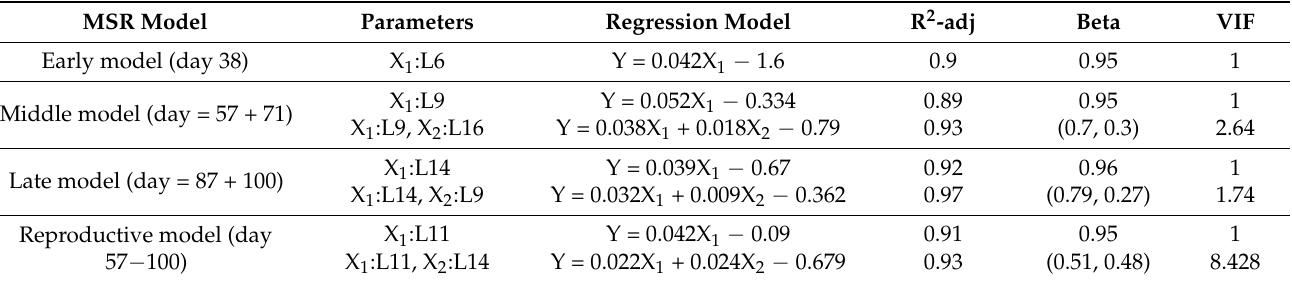
Table 4. Relationships between the leaf chlorophyll content (LCC) and canopy chlorophyll content (CCC) in the 2020